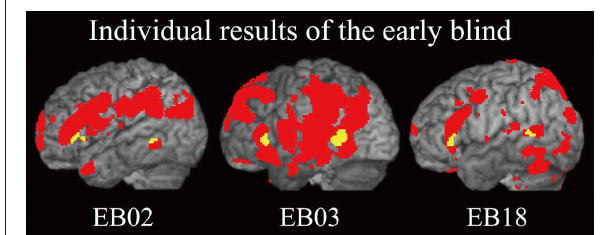
FIGURE 7 | Individual analysis on brain regions activated by identification of facial expressions (relative to that of shoes) in the early blind group. The activation patterns during identification of FEEs relative to shoes were superimposed on a surface-rendered T1-weighted high-resolution MRI of each individual. The yellow-colored regions indicate overlap with regions of activation in the sighted group ( Figure 5B , yellow-colored regions). Note that all of the three individuals were totally blind from birth. The height threshold was set at Z > 2 . 58, uncorrected for multiple